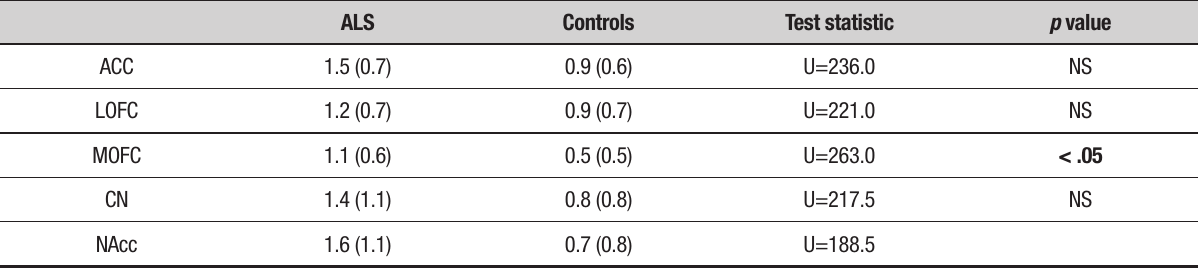
Table 2. Scan Rating comparison (mean and standard deviation) between ALS and control groups ALS Controls Test